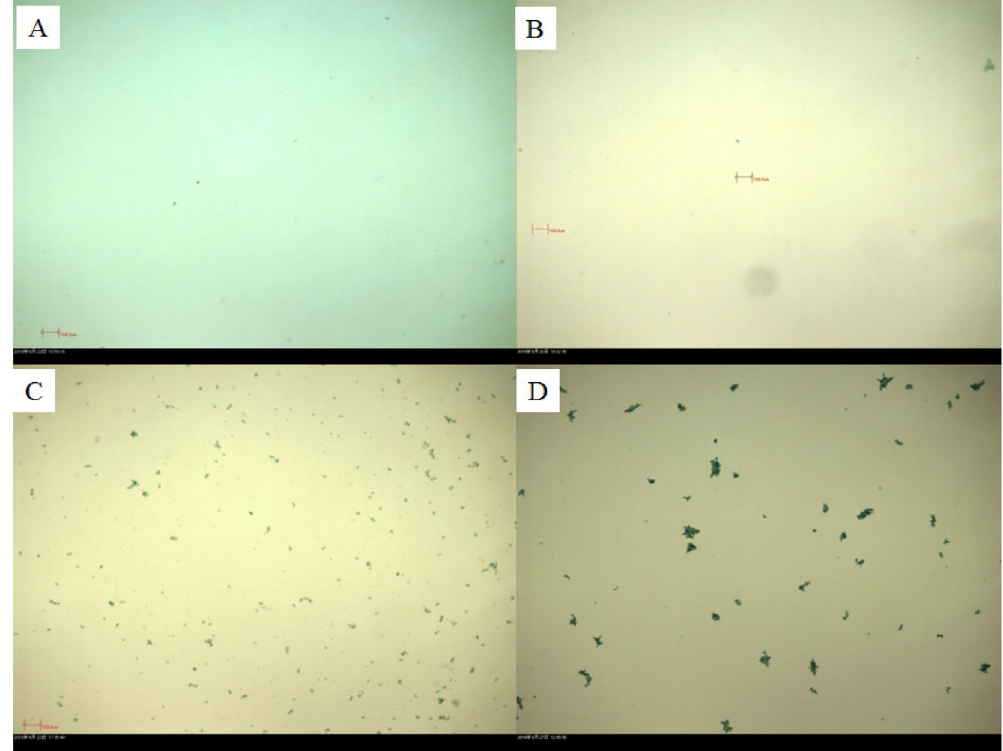
Figure 2. Time-lapse images of EPS to TEP transformation by Alcian Blue dye under sunlight exposures at ( A ) 0 hour, ( B ) 6 hours, ( C ) 19 hours, ( D ) 58 hours. Only daylight exposure hours (12 hours per day) were counted, to the exclusion of night hours. TEP size varied greatly from less than 2 µ m to more than 200 µ m. All the images were taken at 5 ×